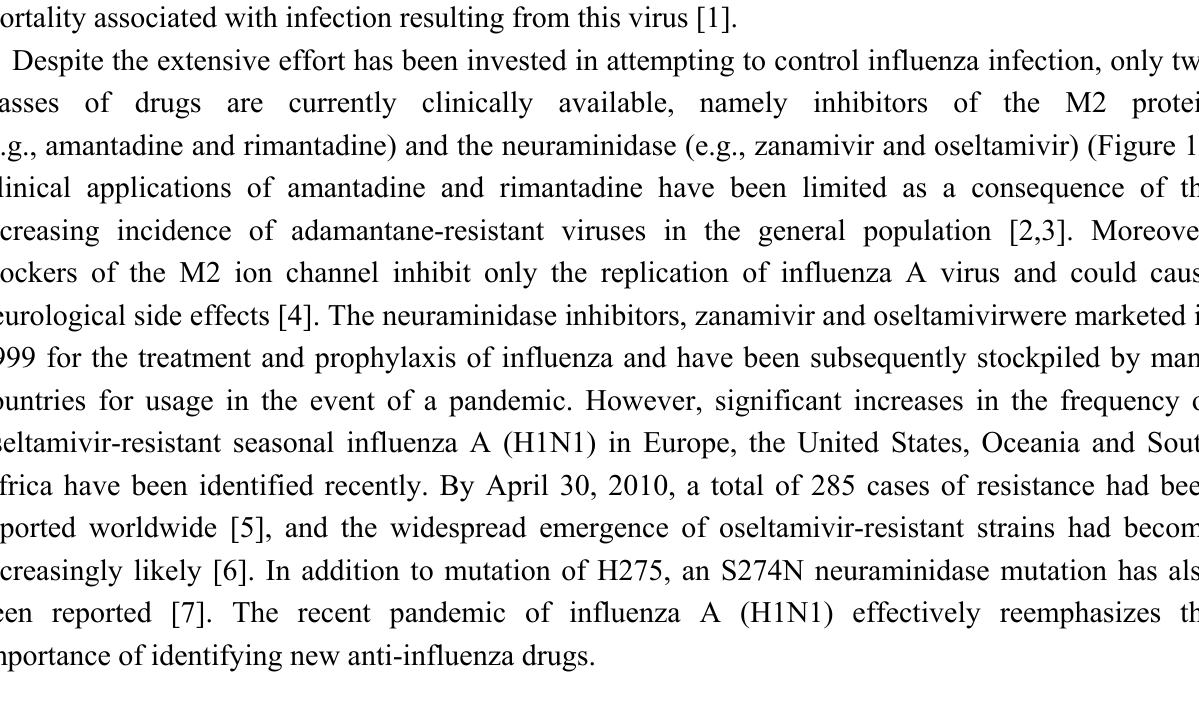
Figure 1. The chemical structures of some anti-influenza drugs and